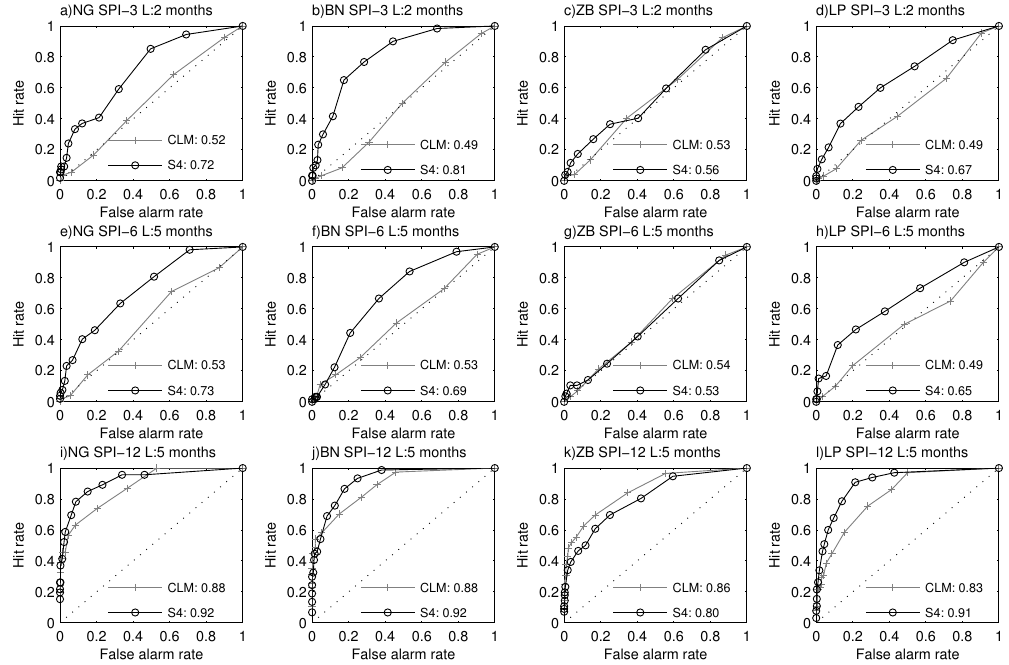
Fig. 8. Relative operating characteristic (ROC) diagram representing hit rate (vertical axis) against false alarm rate (horizontal axis) for the SPI-3 for 2 months lead time (a–d) , the SPI-6 for 5 months lead time (e–h) and the SPI-12 for 5 months lead time (i–l) , given by S4 (black) and CLM (grey) in the different basins (columns). Calculations based on 20 thresholds (fraction of ensemble members below − 1), from 1 (symbols closer to 0.0) to 0 (symbols closer to 1.1). Both S4 and CLM seasonal forecasts were merged with GPCP for the SPI calculation, and the forecasts are verified against the SPI calculated with GPCP. ROC values are given in the legend of each